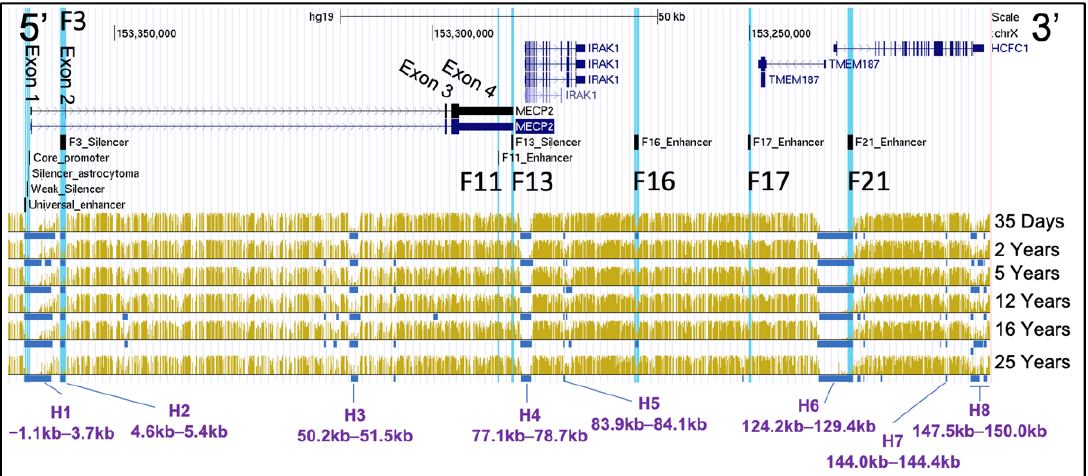
Figure 6. BS-seq of mid-frontal gyrus at different ages. The chrX:153,212,176–153,366,832 genomic region of hg19 human genome assembly is displayed in UCSC genome viewing browser. Direction is 5 ′ –3 ′ (sense orientation relative to the MECP2 gene). Tracks displayed from top to bottom: UCSC genes, mapping of previously identified [55] cis -REs (F3-F21) to genome, BS-seq data tracks: combi- nation of DNA-methyl abundance (yellow) and DNA hypomethylated regions (blue). Cis -REs are highlighted blue in UCSC. Scale on top represents distance equivalent to 50 kb. The MECP2 exons are labeled on UCSC Genes data track. Hypomethylated genomic segments which were consistent between the ages (darker regions) were labeled H1–8. The distances are relative to the first nucleotide of the MECP2 exon 1 (hg19 chrX:153,363,188). Labels include donor age. Yellow peaks represent more mapping reads binding to that specific genomic region, hence higher abundance of methyl-DNA. The methylation data of frontal gyrus of different donors’ ages are from GEO: